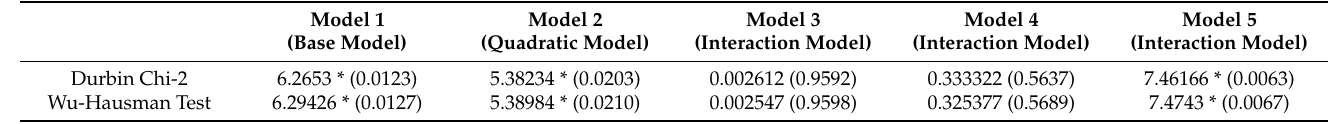
Table 4. Results of the Endogeneity